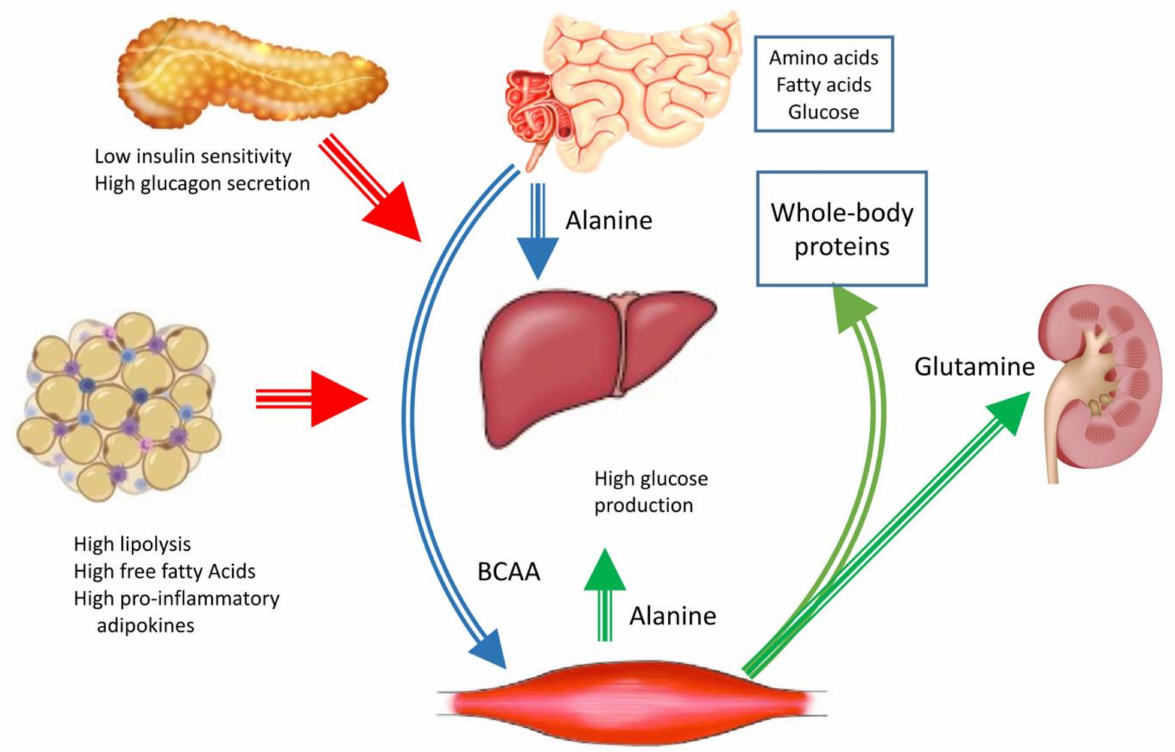
Figure 1. Interorgan amino acid exchange in the postabsorptive state and after meals in diabetes. Note the importance of BCAAs (valine, isoleucine and leucine) as nitrogen carriers to the muscle tissue (lean mass) in the post-prandial period (blue arrows) and the reverse importance of alanine and glutamine as nitrogen carriers to central organs in the post-absorptive state (liver, kidney, intestine) (green arrows). In this context, the regulatory role of the pancreas (altered secretion of insulin and glucagon) and the adipose tissue (lipolysis, release of free fatty acids and inflammatory adipokines in the general circulation, particularly in the post-absorptive state) is pivotal for the regulation of hepatic and whole-body homeostasis (red